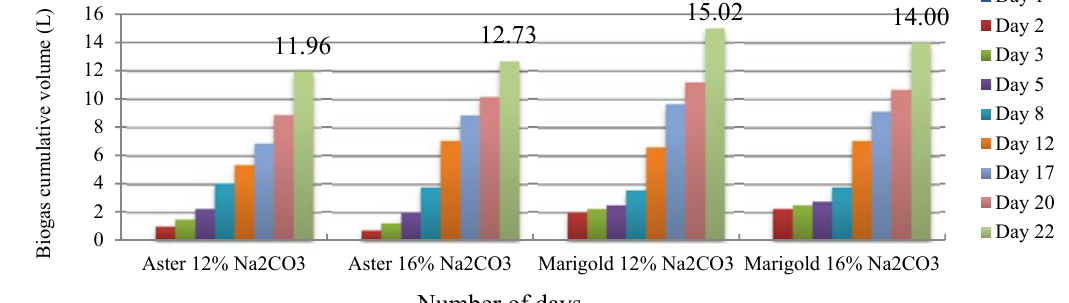
Fig. 4: Biogas generation from aster and marigold flowers (150 g) using sodium carbonate pretreatment